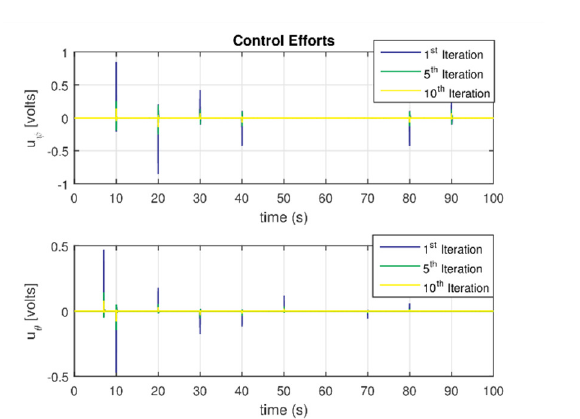
Fig. 12: Control effort at Different Iteration of Hybrid ILC for Reference Trajectory with Sharp Edges